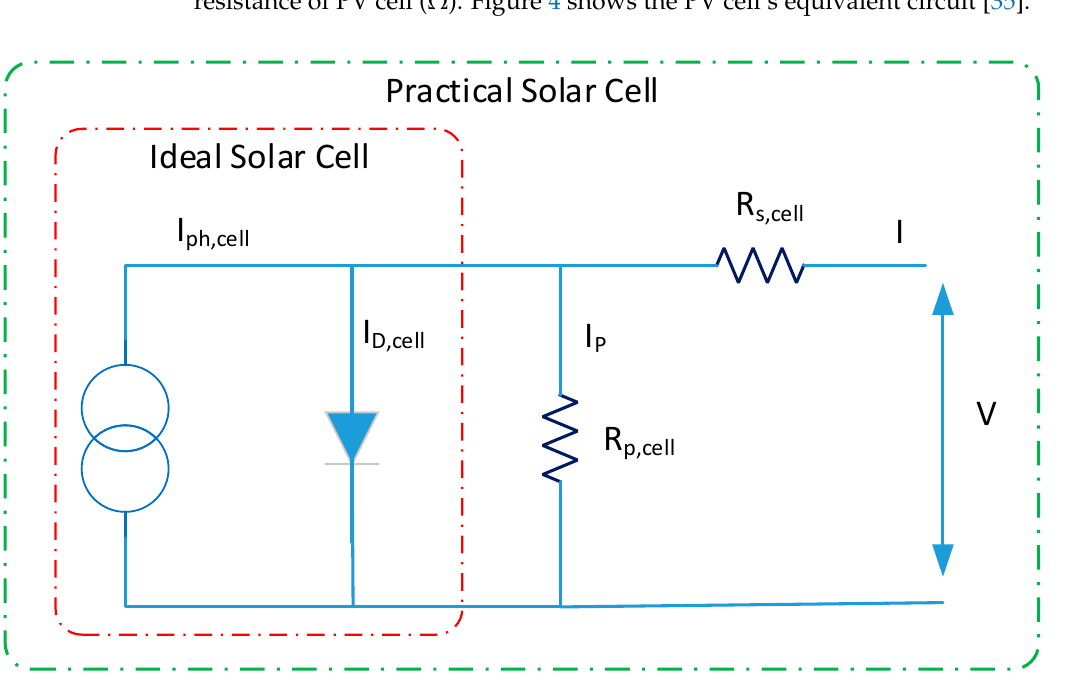
Figure 5. A typical current and voltage curve of photovoltaic.